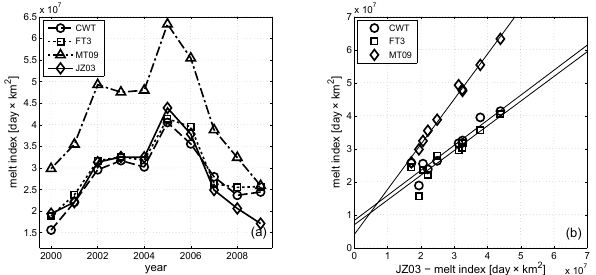
20081.522.533.544.555.566.5x910 2000 2002 2004 2006 Fig. 8. (a) The time series of total melt index (MI), in daykm 2 , for the Antarctic continent plotted for the years 1999 through 2009 de- rived from the FT3 and CWT methods on an enhanced-resolution QuikSCAT active microwave data set along with estimates from the MT09 and M + K30 methods and an SSM/I data set. (b) The corre- lation between the FT3, QuikSCAT data set MI estimates and the CWT, M + K30 and MT09 methods is indicated using a linear re-